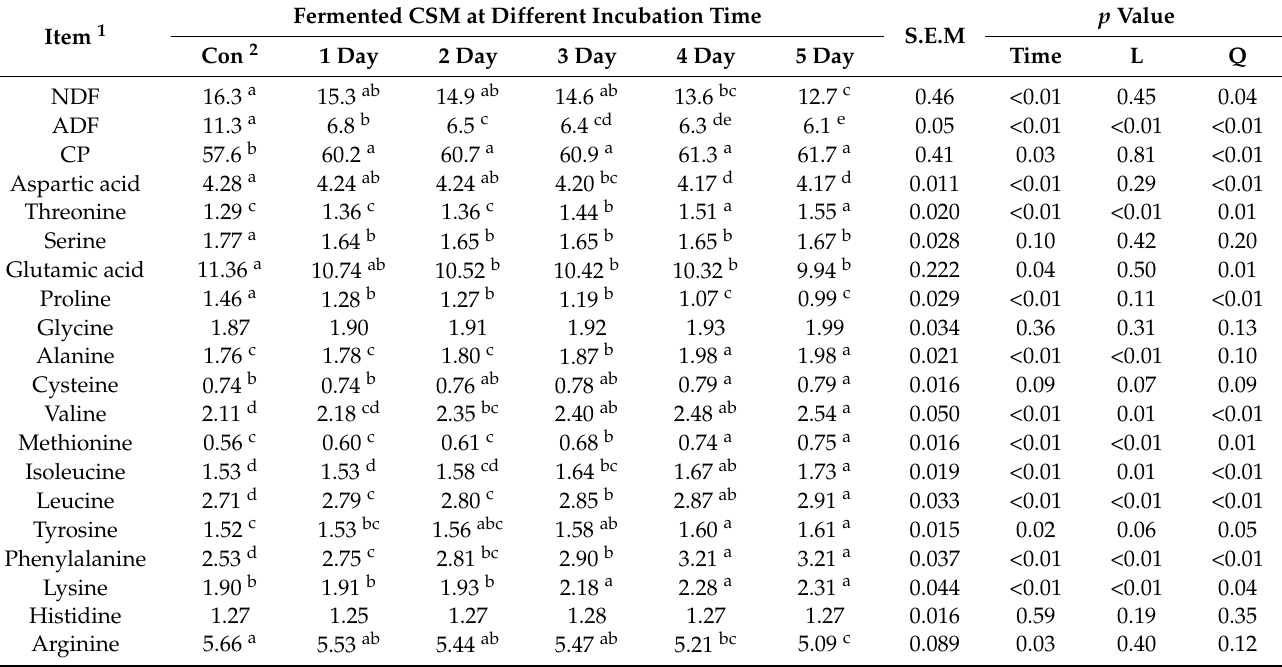
Table 1. Nutritive value of cottonseed meal fermented by L. agilis WWK129 (%,